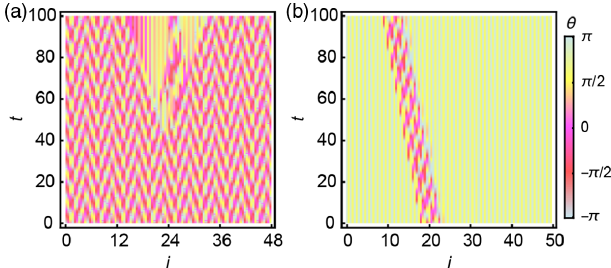
FIG. 8. (a) Time t vs oscillator index i for a perturbed cluster twisted solution with q ¼ 2 and ν ¼ 2 π = 12 with a localized perturbation applied to the center node. (b) Time t vs oscillator index i for the chimera in Fig. 4(c) with a finer timescale. The propagating instability in (a) closely resembles the movement of the incoherent domain in